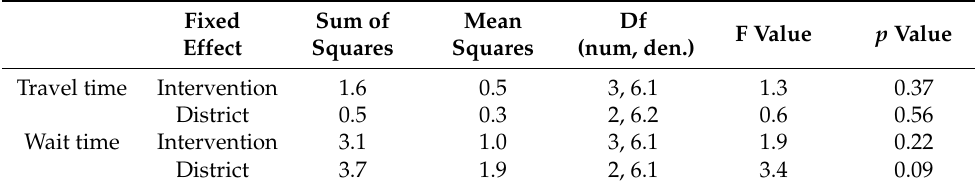
Table 5. Results of F tests on the fixed effects using Satterthwaite approximation in wait and travel time to the central